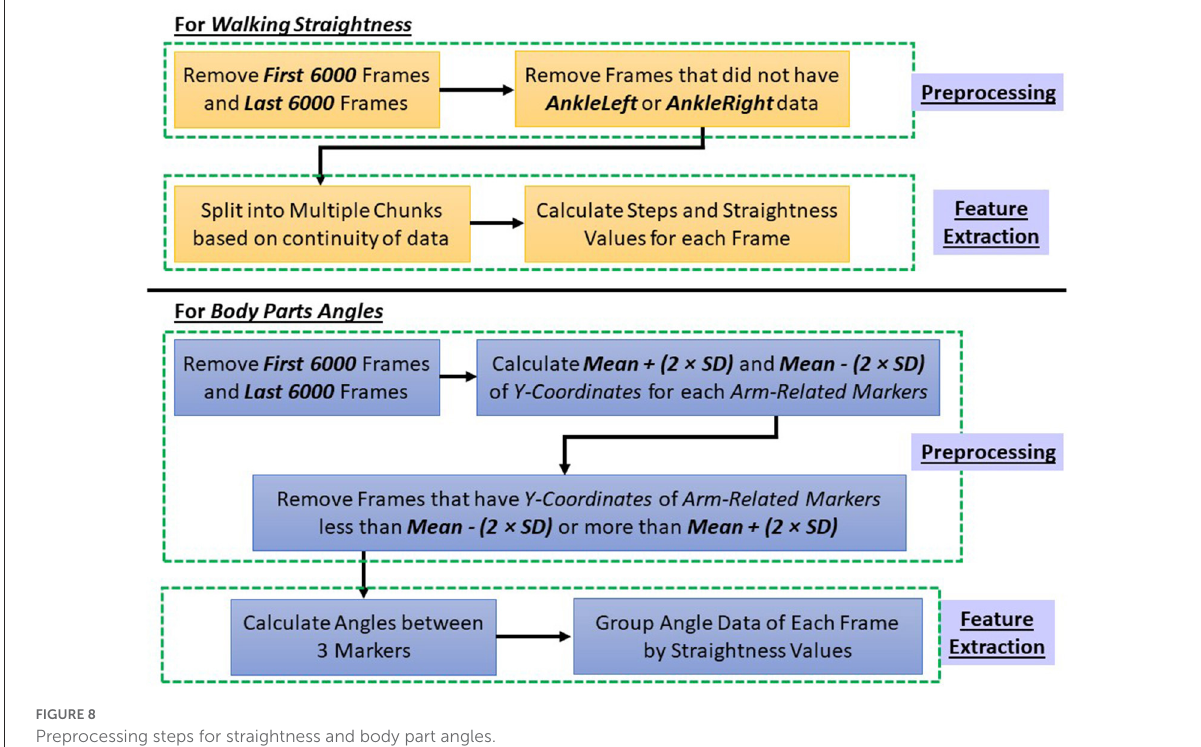
FIGURE8 Preprocessing steps for straightness and body part angles.